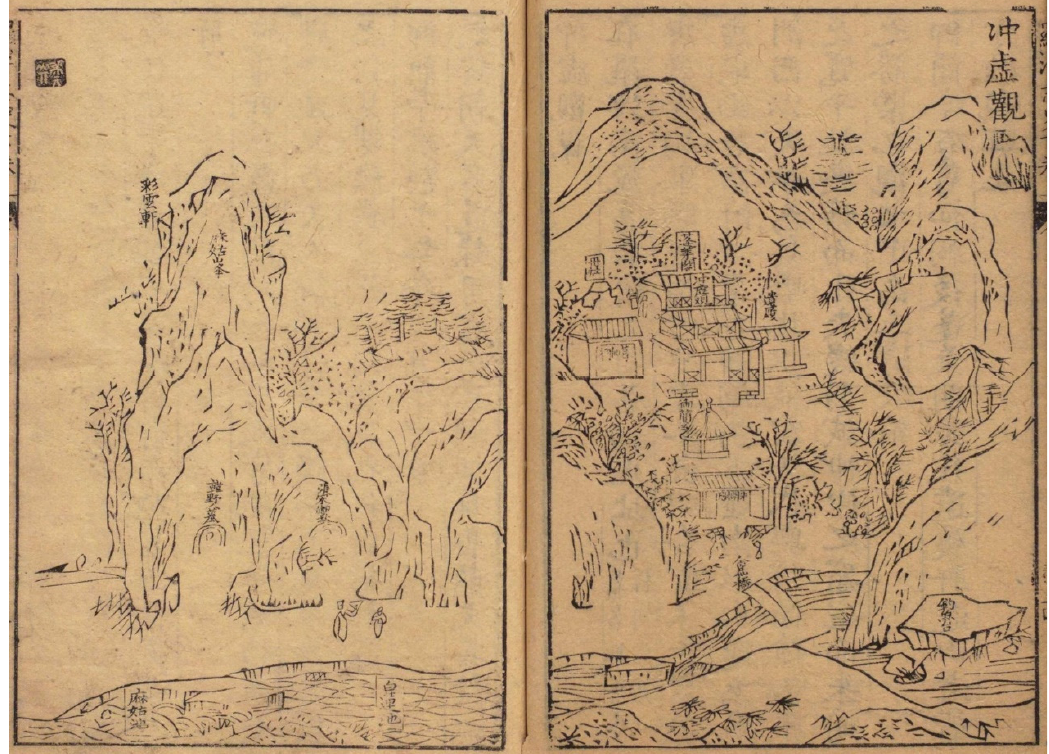
Figure 9. Image of the Chongxu Guan, 1607. Woodblock print. After Han Mingluan, Luofu zhi lue , 1.24b-25a.